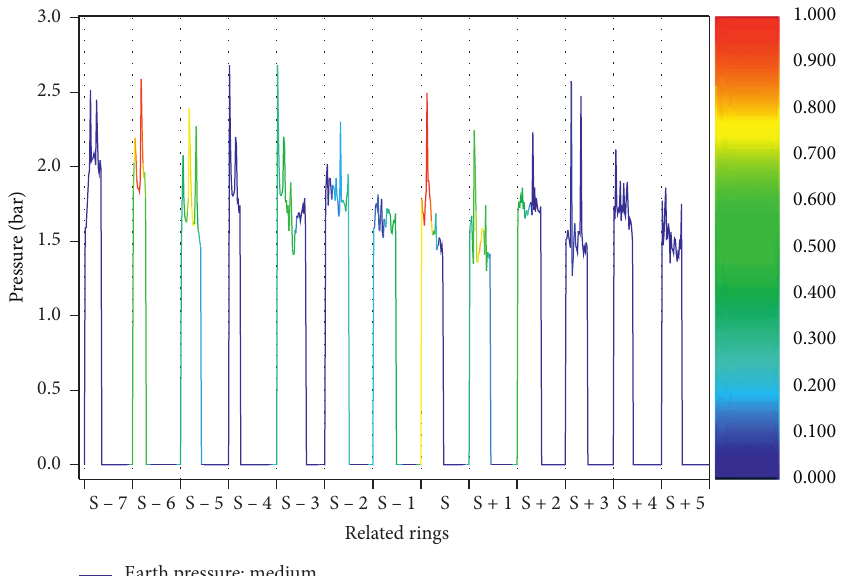
Figure 12: Distribution of the relative weights in class III along the construction